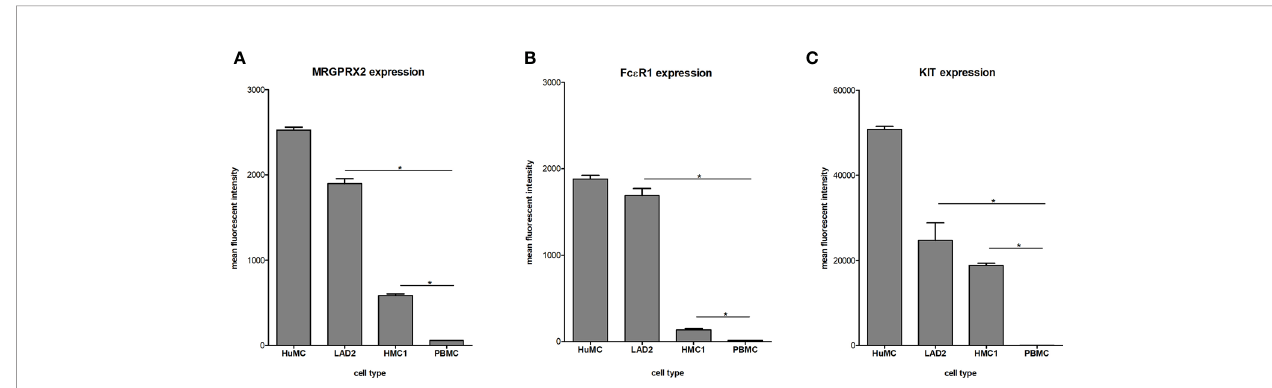
FIGURE 1 | Expression of MRGPRX2 (A) Fc ϵ R1 (B) and KIT (C) by different mast cell lines: HuMC, LAD2, HMC1. Receptor expression was assessed by triple staining and measured by fl owcytometry. The mean fl uorescent intensity (MFI) with SEM is shown of single, live population of HuMC (n=3) and LAD2, HMC1 and PBMCs (all n=6), stained with MRGPRX2-AF488, Fc ϵ RI-APC and cKIT-PE-Cy7. *p<0.05 for MFI compared with